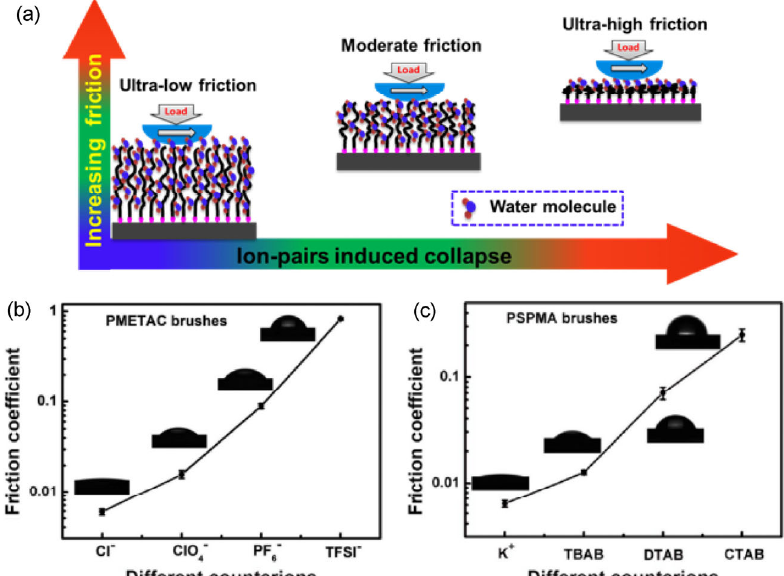
Fig. 11 (a) Illustration of correlation between lubrication and conformation of polymer brushes, changes in friction coe ffi cients and wettability (inserted images) corresponding to (b) and (c). (b) PMETAC brush on Si substrates when the counterions are Cl − , ClO 4 − , PF 6 − , and TFSI − . (c) Polyanionic brushes on Si substrates; the counterions are cationic surfactants (TBAB, DTAB, and CTAB) for PSPMA brushes. Reproduced with permission from Ref. [38]. Copyright American Chemical Society,